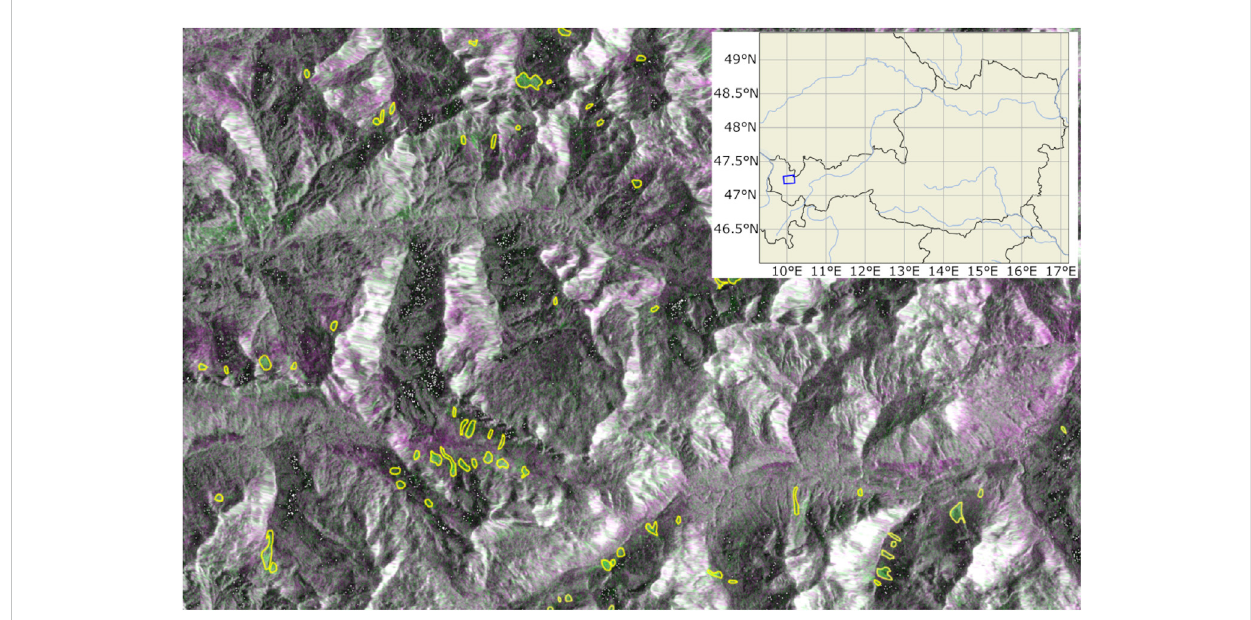
FIGURE 4 Automated avalanche detection from a SAR image of an area in western Austria (inset) with the algorithm from Eckerstorfer et al. (2019). The algorithm produces a RGB change detection image of two Sentinel-1 SAR images of January 28 and 9 February 2016, therefore depicting avalanche activitybetweenthesedates.Anexpertmarkedgreenareaswithyellowoutlineswhentheywereinterpretedasavalanche.Theoriginalimagesweretaken ininterferometricwide swath modewith aresolution of10 ×10 m,indescendinggeometryand with vertical-vertical(VV) polarization. Coordinates are projected in EPSG:32633 - WGS 84/UTM zone 33N. Created with NORCE SAR preprocessing pipeline, QGIS 3.24, Python 3.8, Inkscape 1.2, and Gimp-2.10.